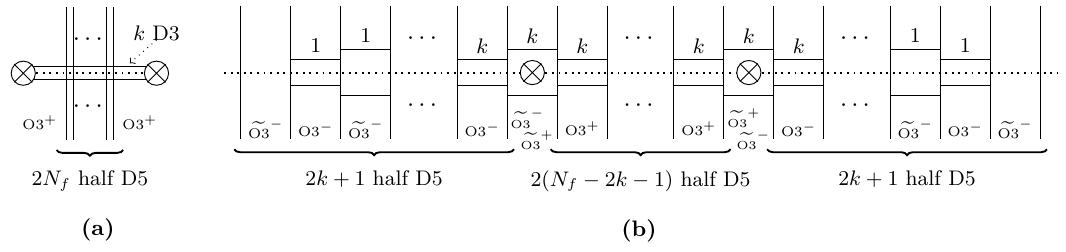
Figure 2. Brane configuration for 3d Sp( k ) with N f fundamental flavours using O3 planes. (See (A.2) for notations.) In (a), the electric phase of the brane configuration is displayed, which gives rise to the Sp( k ) gauge group due to the stack of k full D3s on top of an O 3 + plane. The magnetic phase displayed in (b) is reached by moving 2k half D5 through each of the half NS5s. In the general case N 2 k + 2 , it is convenient to move an additional half D5 through each half NS5. f ≥ The mirror configuration is then derived via S-duality, i.e. exchanging D5 and NS5, and exchanging O 3 + and f O3 − , while O 3 − and f O3 + are